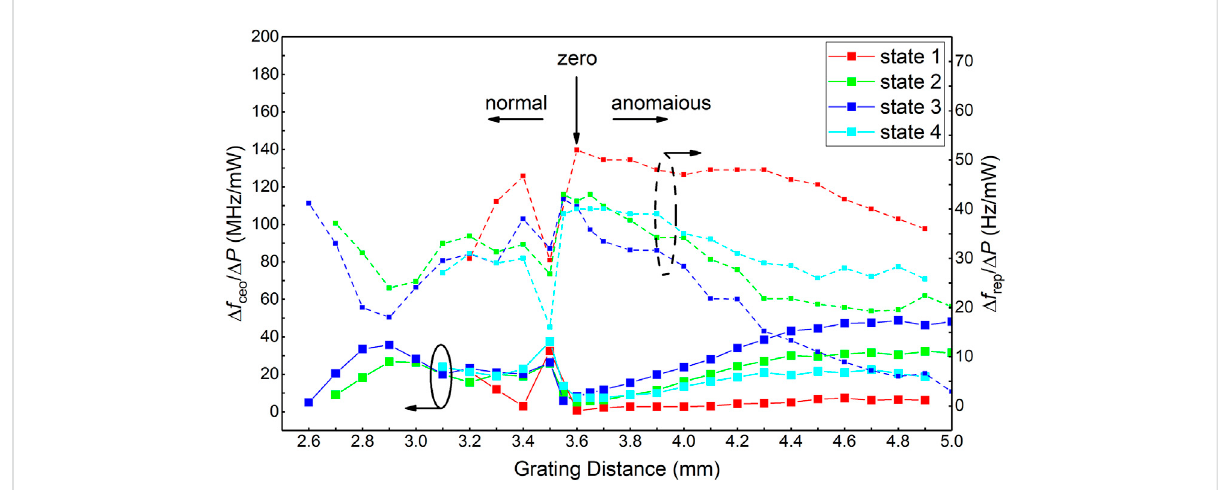
Pump power induced variation of f ceo (solid line) and f rep (dash line) with dispersion and different wave plate setting states.